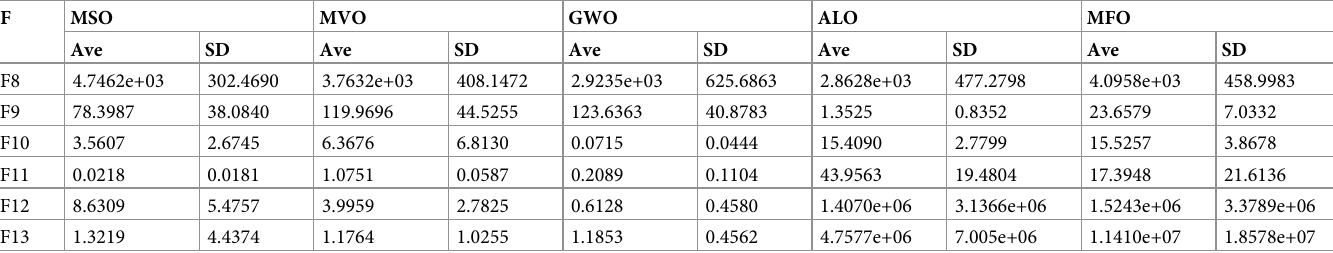
Table 4. Results of multi-modal benchmark